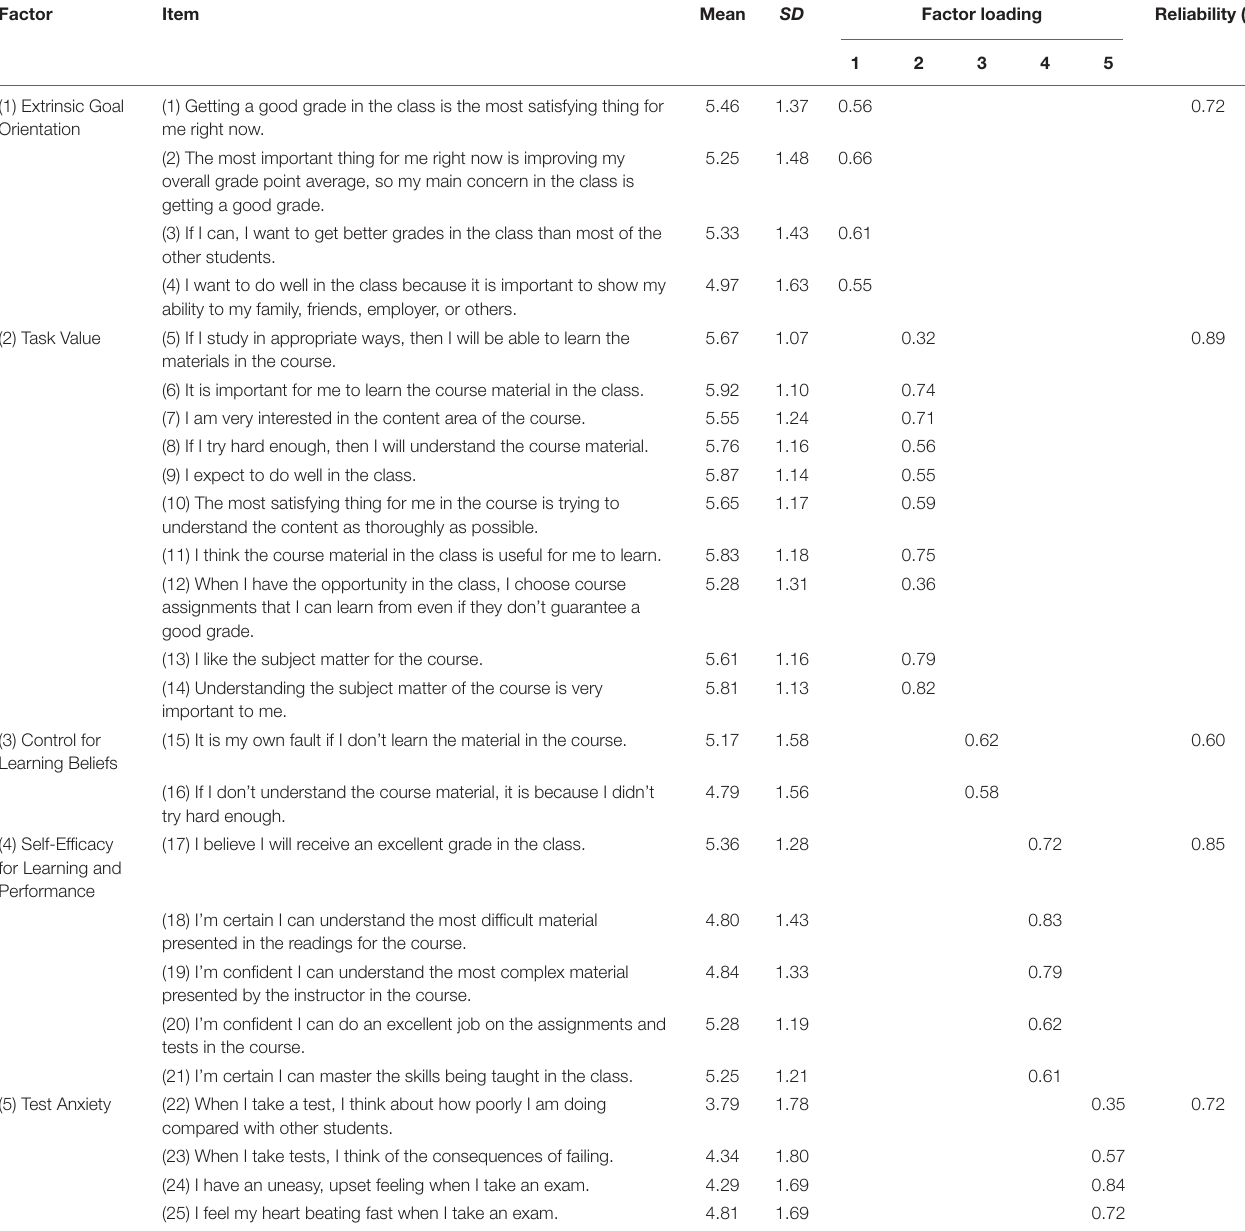
TABLE 1 | Exploratory factor analysis results for motivation items. Factor Item Mean SD Factor loading Reliability ( α